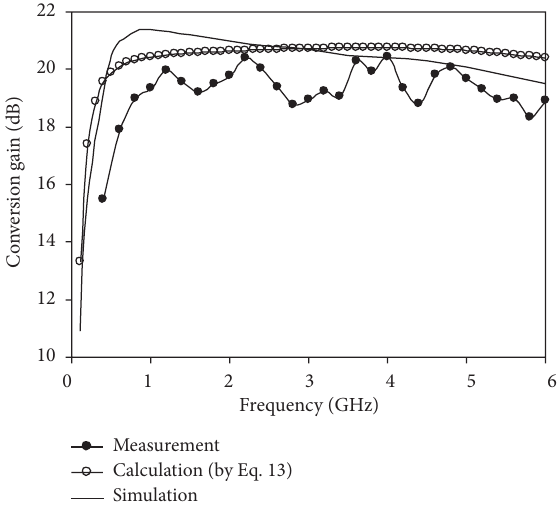
Figure 5: Input matching of the proposed receiver front-end.